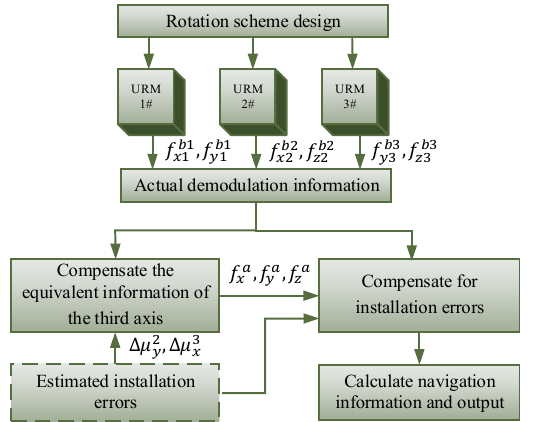
Figure 4. A block diagram of compensating for installation